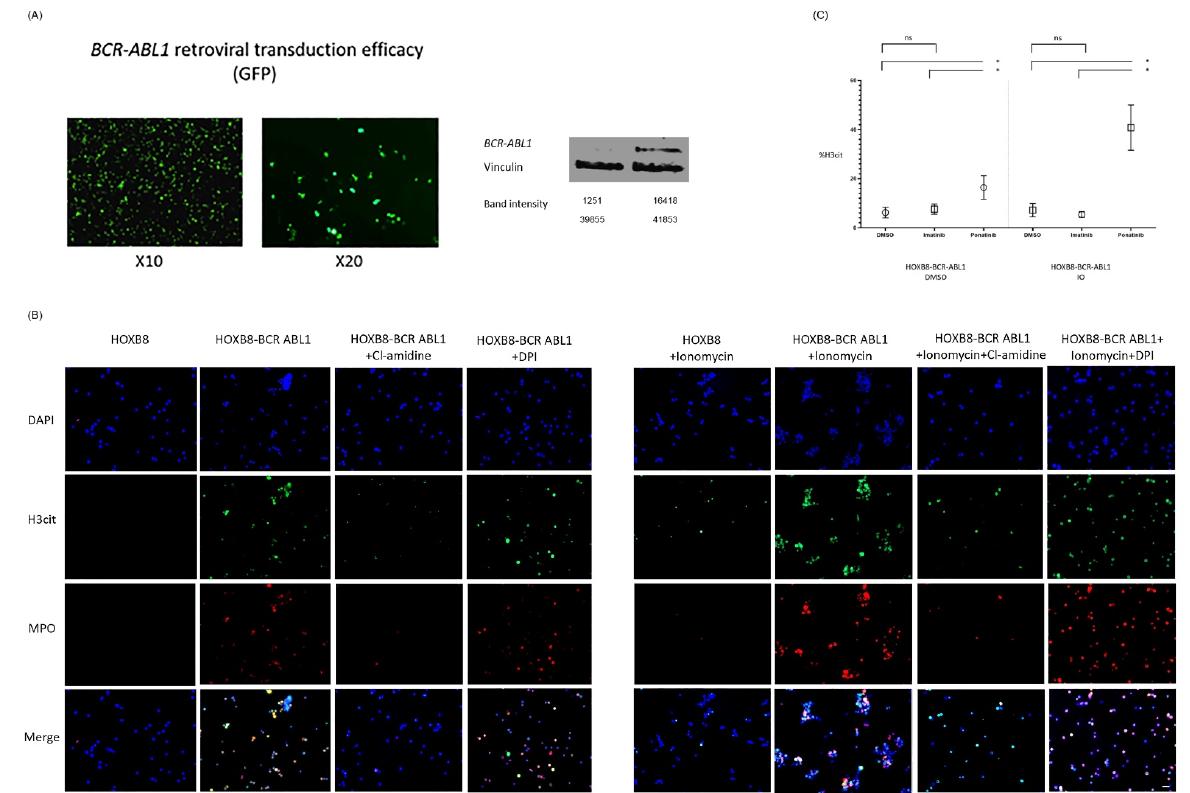
Figure 3. ( A ) Green fluorescent protein (GFP) and BCR-ABL1 expression to assess retroviral transduction efficacy of HoxB8 cells using the MSCV-(pBabe mcs)-human p210 -BCR-ABL -IRES-GFP system. Complete blot analysis can be found in the Supplementary file (Figure S6). ( B ) HoxB8 - BCR- ABL1 cells and HOXB8 cells transduced with an empty vector were stimulated with IO and treated or not with Cl-amidine, a PAD4 inhibitor (10 µM) or diphenyleneiodonium (DPI), a nicotinamide adenine dinucleotide phosphate (NADPH) oxidase inhibitor (1 4 µM) and stained with DAPI, anti-H3cit and anti-myeloperoxidase (MPO). Scale bar, 100 µm. ( C ) Percent of H3cit in HoxB8-BCR-ABL1 cells and HoxB8 cells transduced with an empty vector stimulated with 4 µM IO for 2 h and exposed to DMSO, imatinib (5.3 µM) or ponatinib (0.17 µM). * p < 0.05; ns—non-significant. Consistent with our ex-vivo results, initial studies show that our HoxB8 - BCR-ABL1 cell line demonstrates an increase in H3cit and MPO expression. In addition, we showed co-localization of DNA (DAPI stained) with MPO and H3cit, a trait characteristic of NET formation. Exposing the cells to a PAD4 inhibitor, Cl-amidine, resulted in a dramatic de- crease of H3cit and MPO expression. In contrast, inhibiting NADPH oxidase did not alter the expression of H3cit and MPO (Figure 3B). Pre-treating HoxB8-BCR-ABL1 cells and HOXB8 cells transduced with an empty vec- tor with different TKIs resulted in TKI-dependent differential response. In the BCR-ABL1 transduced cells, ponatinib significantly increased H3cit expression as compared to DMSO and imatinib-treated cells in an unstimulated condition ( p < 0.05 for all compari- sons). In the stimulated condition, ponatinib also significantly increased H3cit expression as compared to DMSO and imatinib-treated cells ( p < 0.05 for all comparisons) (Figure 3C). Taken together, these data suggest that in the HoxB8 cell system, BCR-ABL1 is asso- ciated with increased NET formation that is further augmented by ponatinib in a PAD4- dependent fashion.